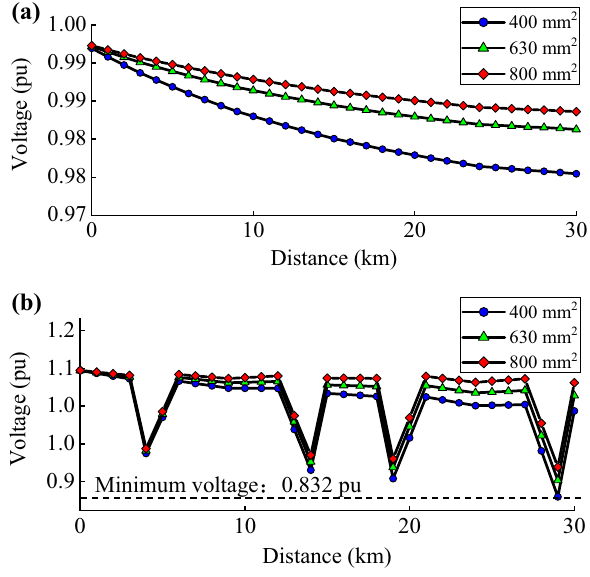
Fig. 17 Voltage distribution of DC 1500 V system at closely run- ning: a medium-voltage network; b traction